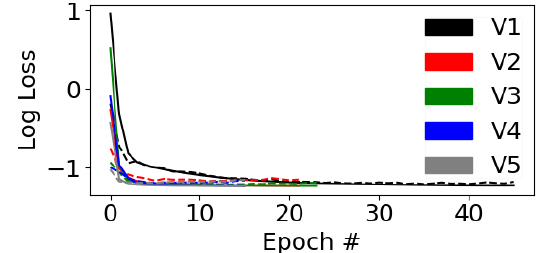
Figure 6. The learning curves of the different H-DSPEB architectures used in the